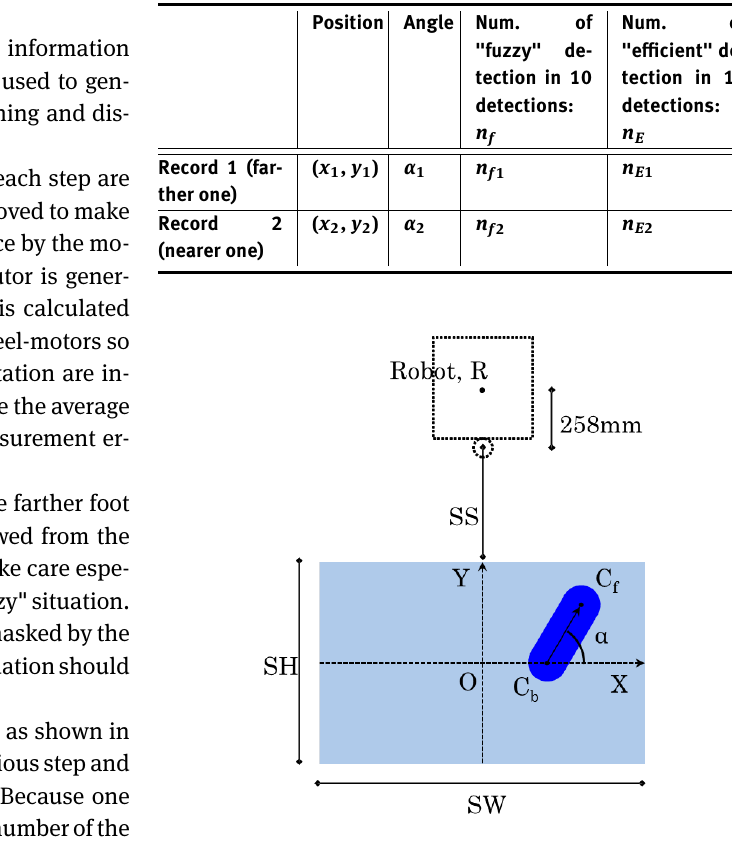
Fig. 15. Displaying Footmark in Projection Screen